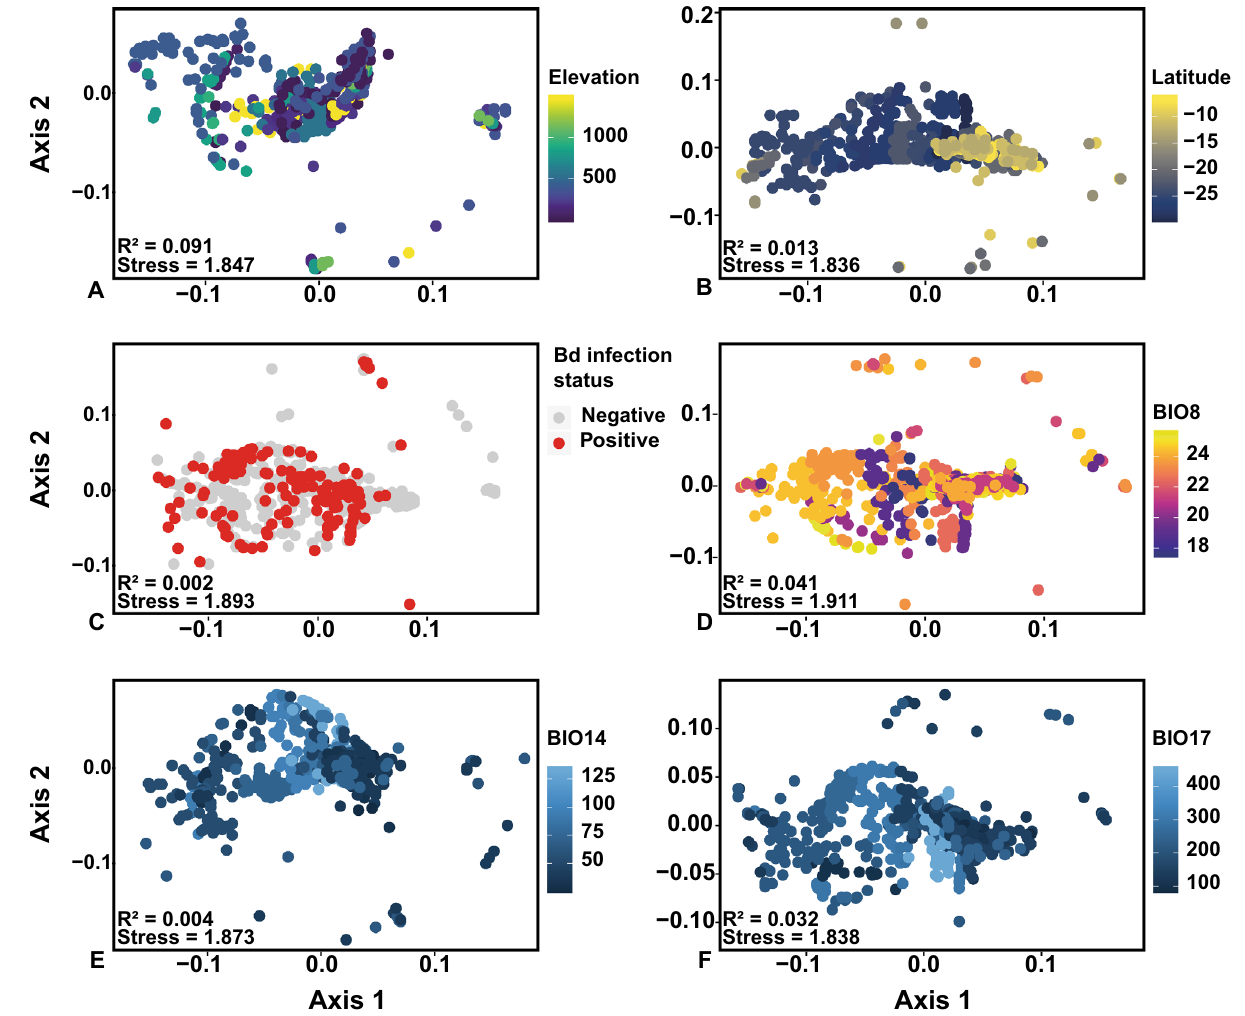
Figure 4. Beta diversity of amphibian skin bacterial communities is significantly structured by ( A ) elevation (m), ( B ) latitude, ( E ) Precipitation of the Wettest Month (mm, Bio14), and ( F ) Precipitation of the Driest Quarter (mm, Bio17), but not by ( C ) Bd infection status across the Brazilian Atlantic Forest and ( D ) Mean Temperature of the Wettest Quarter (°C, Bio8). Non- metric multidimensional scaling (NMDS) plot of Bray– Curtis distances. Each point represents the skin bacterial community of an individual treefrog, symbol color indicates variable